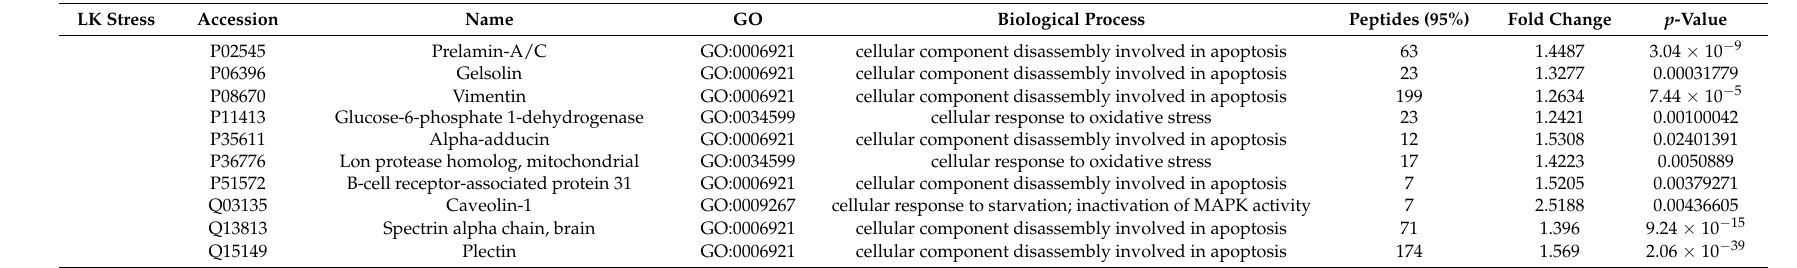
Table 5. Summary of significant up-regulated stress-related proteins identified in iTRAQ of hADSCs treated with LK. LK